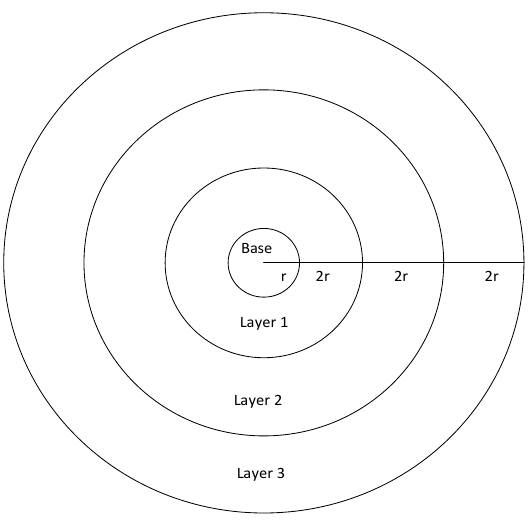
Figure 8. Networks layer model.